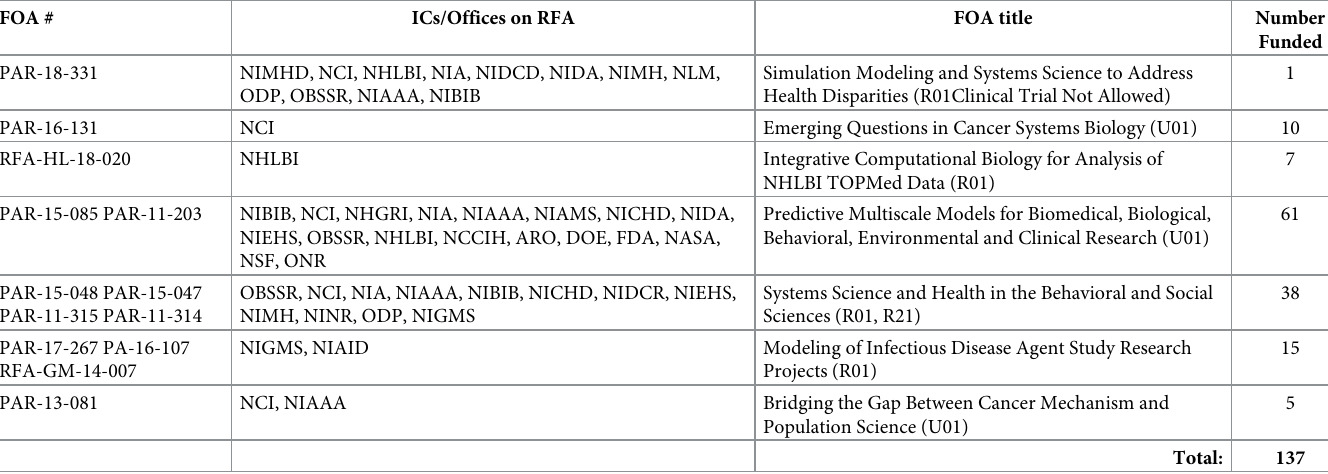
Table 1. Funding opportunity announcements selected for inclusion in phase I of the portfolio analysis (N =